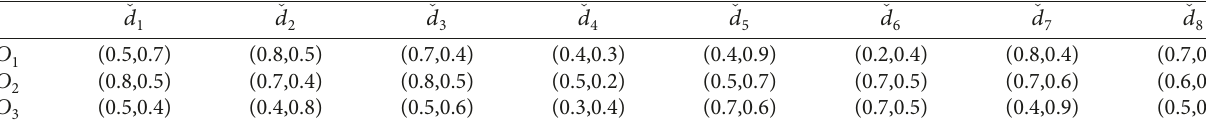
Table 5: PFHS decision matrix for H 5